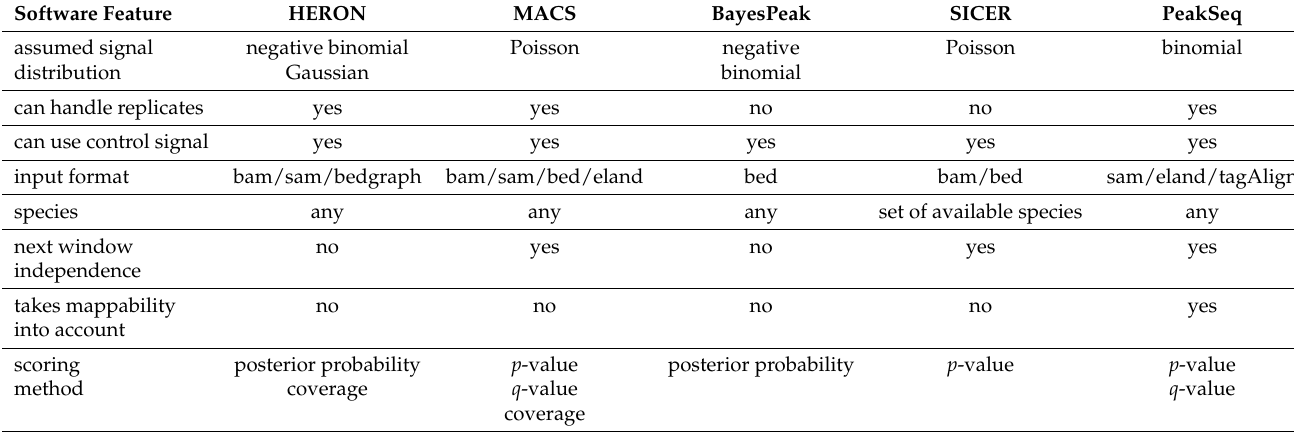
Table 1. Comparison of different peakcalling tools available with respect to their features including the newly proposed HERON